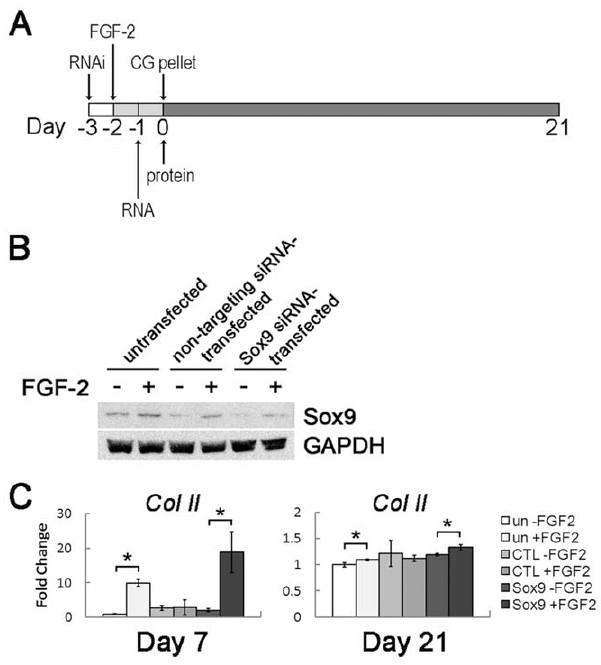
Figure 6. FGF-2 enhances hMSC CG partially through a Sox9- mediated mechanism. (A) RNAi experiments were performed to knockdown Sox9 expression. Human MSCs were transfected with siRNA targeted to Sox9 or non-targeting siRNA. 24 hours after transfection, hMSCs received FGF-2, and 72 hours after transfection, hMSCs were differentiated into the chondrogenic lineage in pellet culture. Sox9 knockdown was verified 48 and 72 hours after transfection by gene and protein analysis, respectively. (B) Western blot analysis showed that Sox9 levels were lower in both FGF-2- ( + ) and non-FGF-2-treated ( 2 ) hMSCs transfected with Sox9 siRNA compared to untransfected and non-targeting siRNA-transfected hMSCs. With each treatment, FGF-2 increased Sox9 levels. ( C) After transfected hMSCs were differentiated into the chondrogenic lineage, real-time RT-PCR analysis showed that knockdown of Sox9 expression did not result in a concomitant decrease in Col II gene expression 7 and 21 days after pellet formation. However, FGF-2 pretreatment led to a significant increase in Col II gene expression in untransfected and Sox9 siRNA-transfected hMSCs.